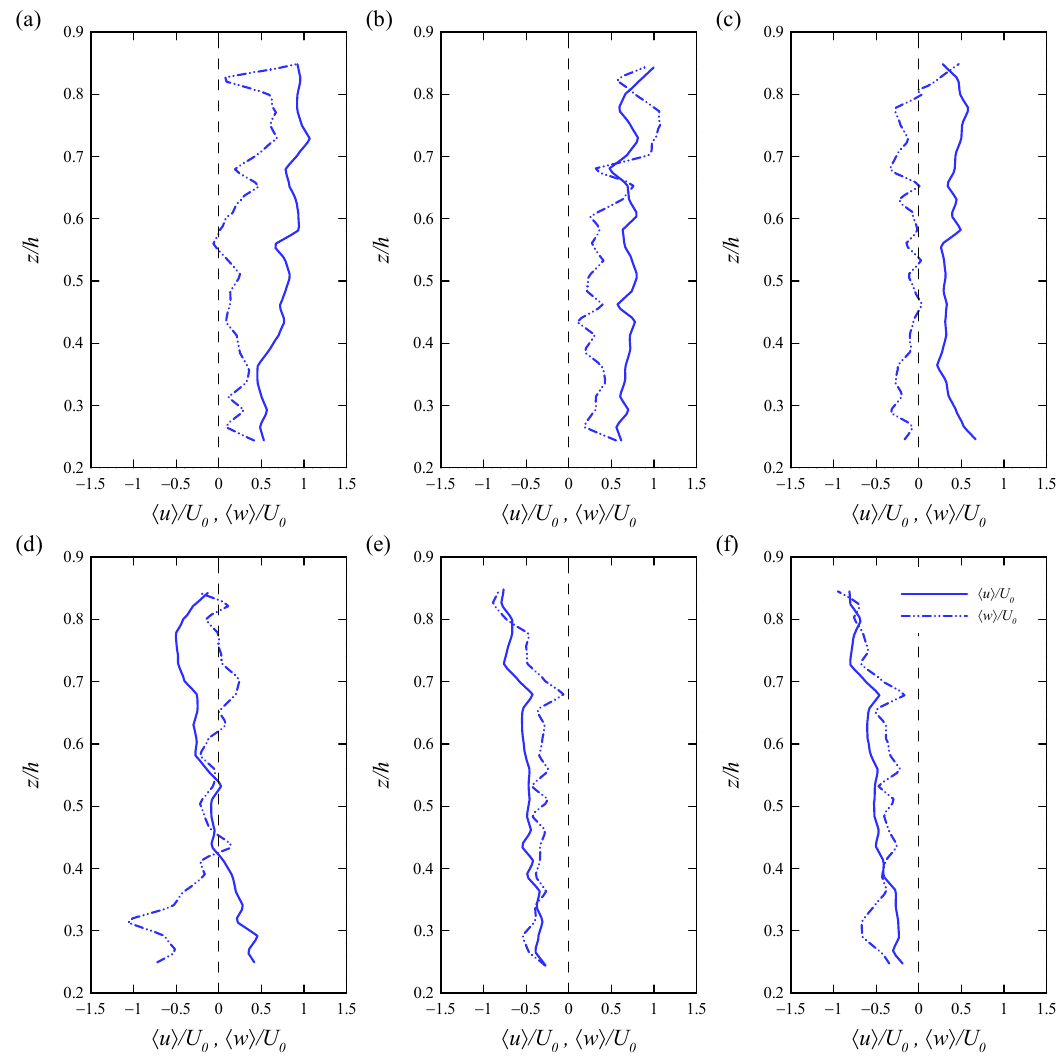
Figure 12. Longitudinal and vertical phase-averaged velocity profiles normalized by U 0 at x / h = − 0.11 and ( a ) t / T = 0, ( b ) t / T = 0.06, ( c ) t / T = 0.15, ( d ) t / T = 0.27, ( e ) t / T = 0.38, and ( f ) t / T =